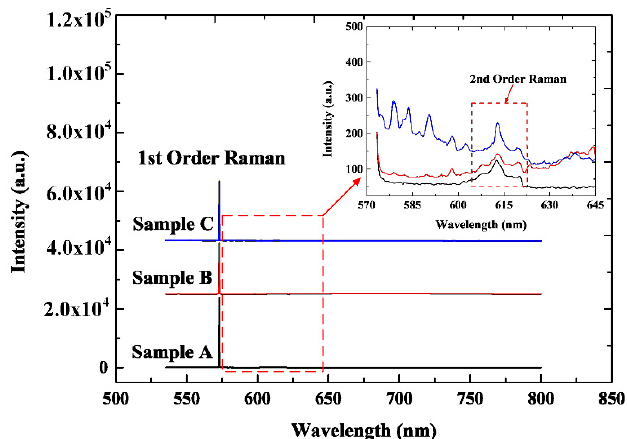
Figure 7. Photoluminescence spectra of Samples A, B, and C, indicating the high purity of the diamond films. Inset: Magnified view of area enclosed by red dashed rectangle. Spectra were vertically offset for clarity.